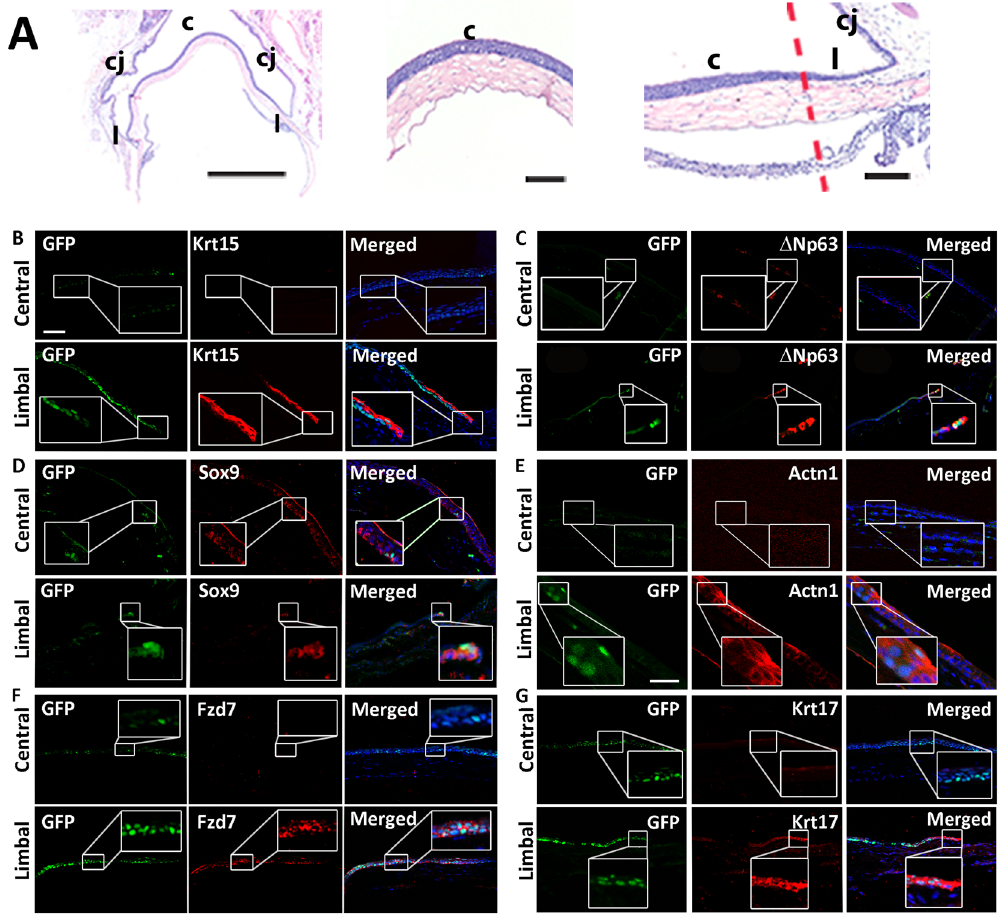
Figure 6. K5Tta × TRE-H2BGFP + slow cycling cells co-localize with corneal stem cell markers. ( A ) Low power haemotoxylin and eosin staining of the adult cornea, limbus and conjunctiva tissue (left), magnified images of the central cornea (middle) and limbal cornea (right). ( B – G ) Corneal immunofluorescence staining of K5Tta × TRE-H2BGFP sections, co-stained with putative stem cell markers in the central (upper panels) and limbal cornea (lower panels). ( B ) At 35 day chase (n = 3) few lowly expressed GFP + cells were found in the central cornea while Krt15 (red) antibody staining is not expressed. At the limbus, there is high GFP + LRC staining at the limbal and periphery basal layer, including to one cell layer above in some areas with weaker expression. Krt15 and few GFP + cells co-localize in limbal cells as shown in the merged panel. ( C ) In the central cornea, GFP + LRCs at 53 d chase (n = 3) and Δ Np63 (red) labeled staining was absent. At the limbus, GFP + LRCs were localized to 2–3 cells at the limbus and Δ Np63 expression was limbal and basal specific (nuclear expression). The merged image shows the co-localization of GFP and Δ Np63. ( D ) GFP + LRCs at 53 d chase localized to a few cells in the central cornea (boxed) while Sox9 (red) marked only basal epithelial cells (n = 6). The merged image co-localizes them together. At the limbus, GFP + LRCs co-localized with Sox9. ( E ) GFP + LRCs from 53 d chase were not detected and Actn1 was devoid of staining in the central cornea. At the limbus, few GFP + cells were visible and co-localized to cytoplasmic Actn1 staining (n = 4). ( F ) GFP + LRCs cells at 35 d chase are strongly expressed in the basal and some suprabasal layers of the central cornea, while some weak staining was also observed in cells of the suprabasal layer. Fzd7 staining in the central cornea is devoid of any expression, while at the limbus, the expression is basal and co-localized to GFP + LRCs (n = 2) ( G ) GFP + LRCs are strongly expressed in the basal and some suprabasal layers of the central cornea, while some weak staining was also observed in cells of the suprabasal layer. Krt17 staining was absent in the central cornea, but co- localized with GFP + LRCs at the limbus (n = 3). Scale bar in A = 200 µ m for ( A – C , E , F ); in D scale bar = 50 µ